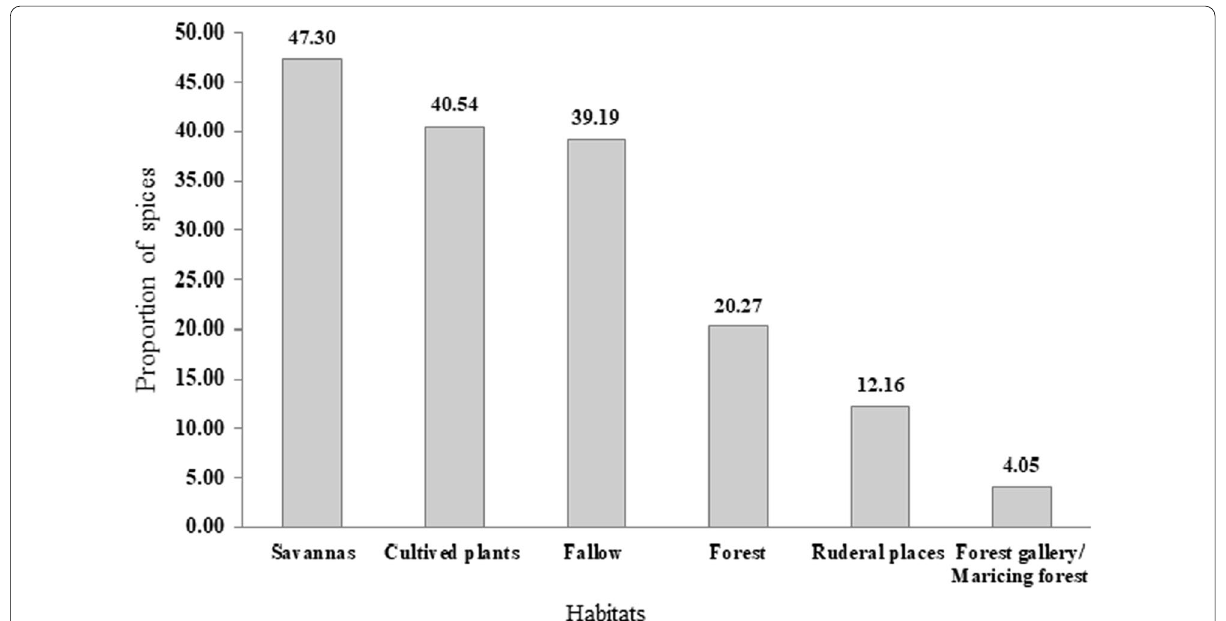
Fig. 3 Habitats of anti-snakebite plants reported by traditional medicine practitioners in Bénin